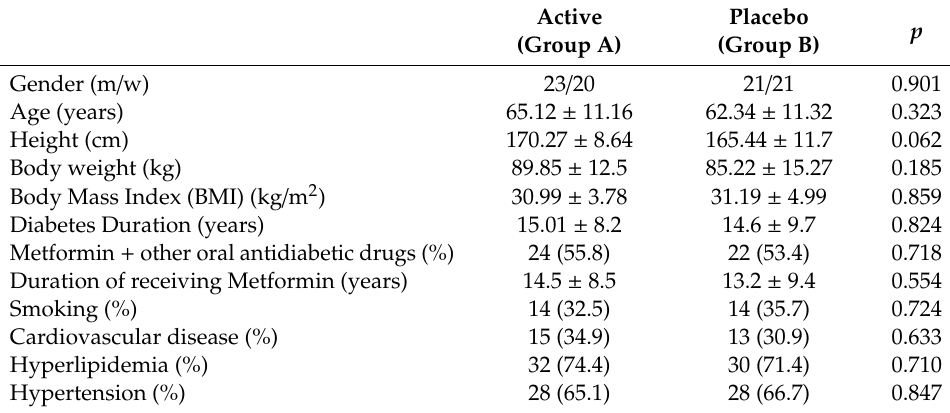
Table 1. Demographic characteristics of the study population at the baseline.